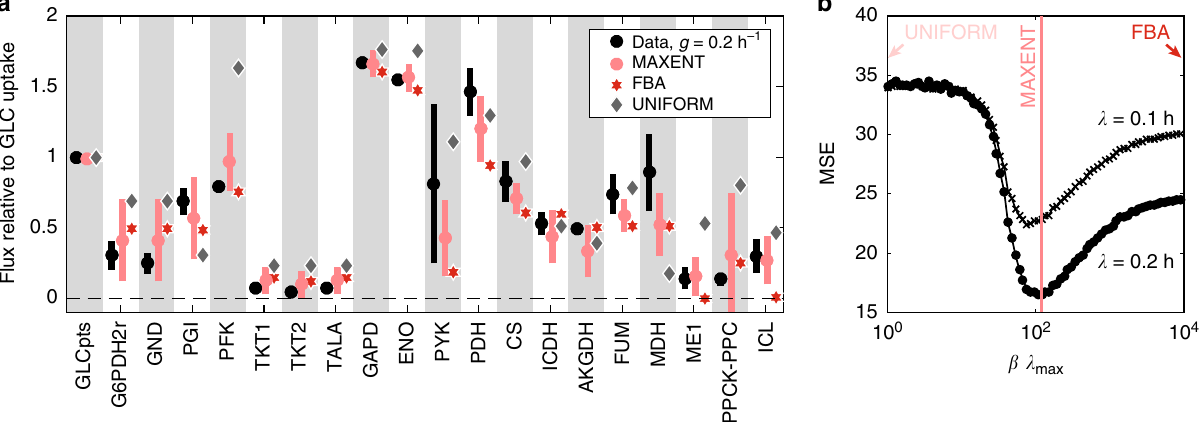
Fig. 2 a Comparison of measured fl uxes (black, mean, error bars de fi ned as SD over 12 experiments, technical replicates; normalized to glucose uptake) with predictions of FBA (red stars) and of the maximum entropy model (pink, error bars de fi ned as SD with simulation sample size 10 5 ). Also shown are mean fl uxes predicted by uniform sampling, i.e., using β = 0 in Eq. (7) (gray stars; mean, for clarity, large SDs are not displayed). Data for a are a collection of 12 experiments at average growth rate (cid:1) λ ¼ 0 : 2 h (cid:2) 1 . Wild-type E. coli was grown in glucose-limited medium in aerobic conditions. b Quality of fl ux predictions, quanti fi ed as mean-squared error or MSE in Eq. (1) between fl ux measurements and the maximum entropy predictions, as a function of dimensionless βλ max parameter. Two curves correspond to models inferred at two different average growth rates, (cid:1) λ ¼ 0 : 2 h (cid:2) 1 (data from a ) and (cid:1) λ ¼ 0 : 1 h (cid:2) 1 (Supplementary Data 1). Maximum entropy models for both growth rates coincide at an intermediate value of β * λ max ≈ 120 (pink line) and provide a better fi t than the uniform ( β = 0) or FBA ( β → ∞ )